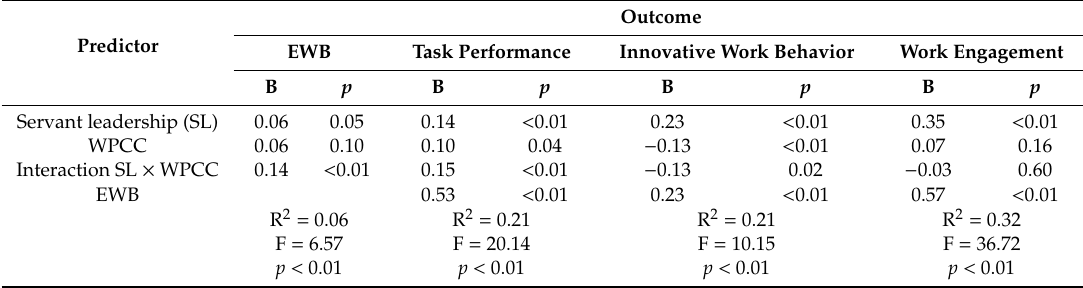
Table 3. Results of moderated mediation analysis: The relationship between servant leadership and work outcomes as mediated by EWB and moderated by WPCC. Outcome Predictor EWB Task Performance Innovative Work Behavior Work